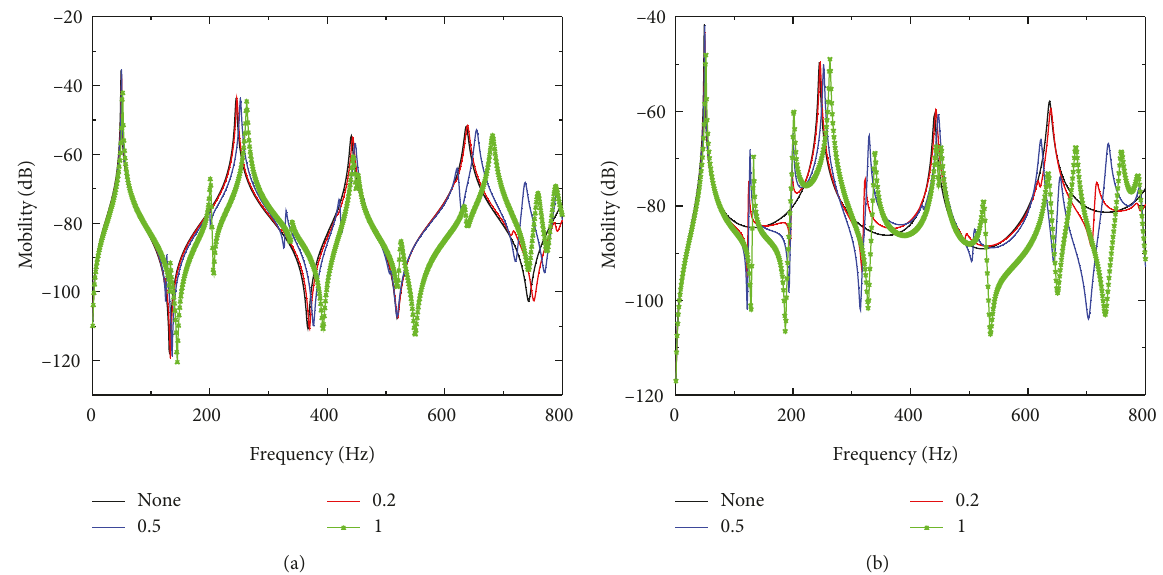
Figure 7: Mobility characteristics for square plate with one beam of different lengths located at its diagonal line under unit force ( q (a) Point C (0.5m, 0.5m). (b) Point D (0.25 m, 0.25m).